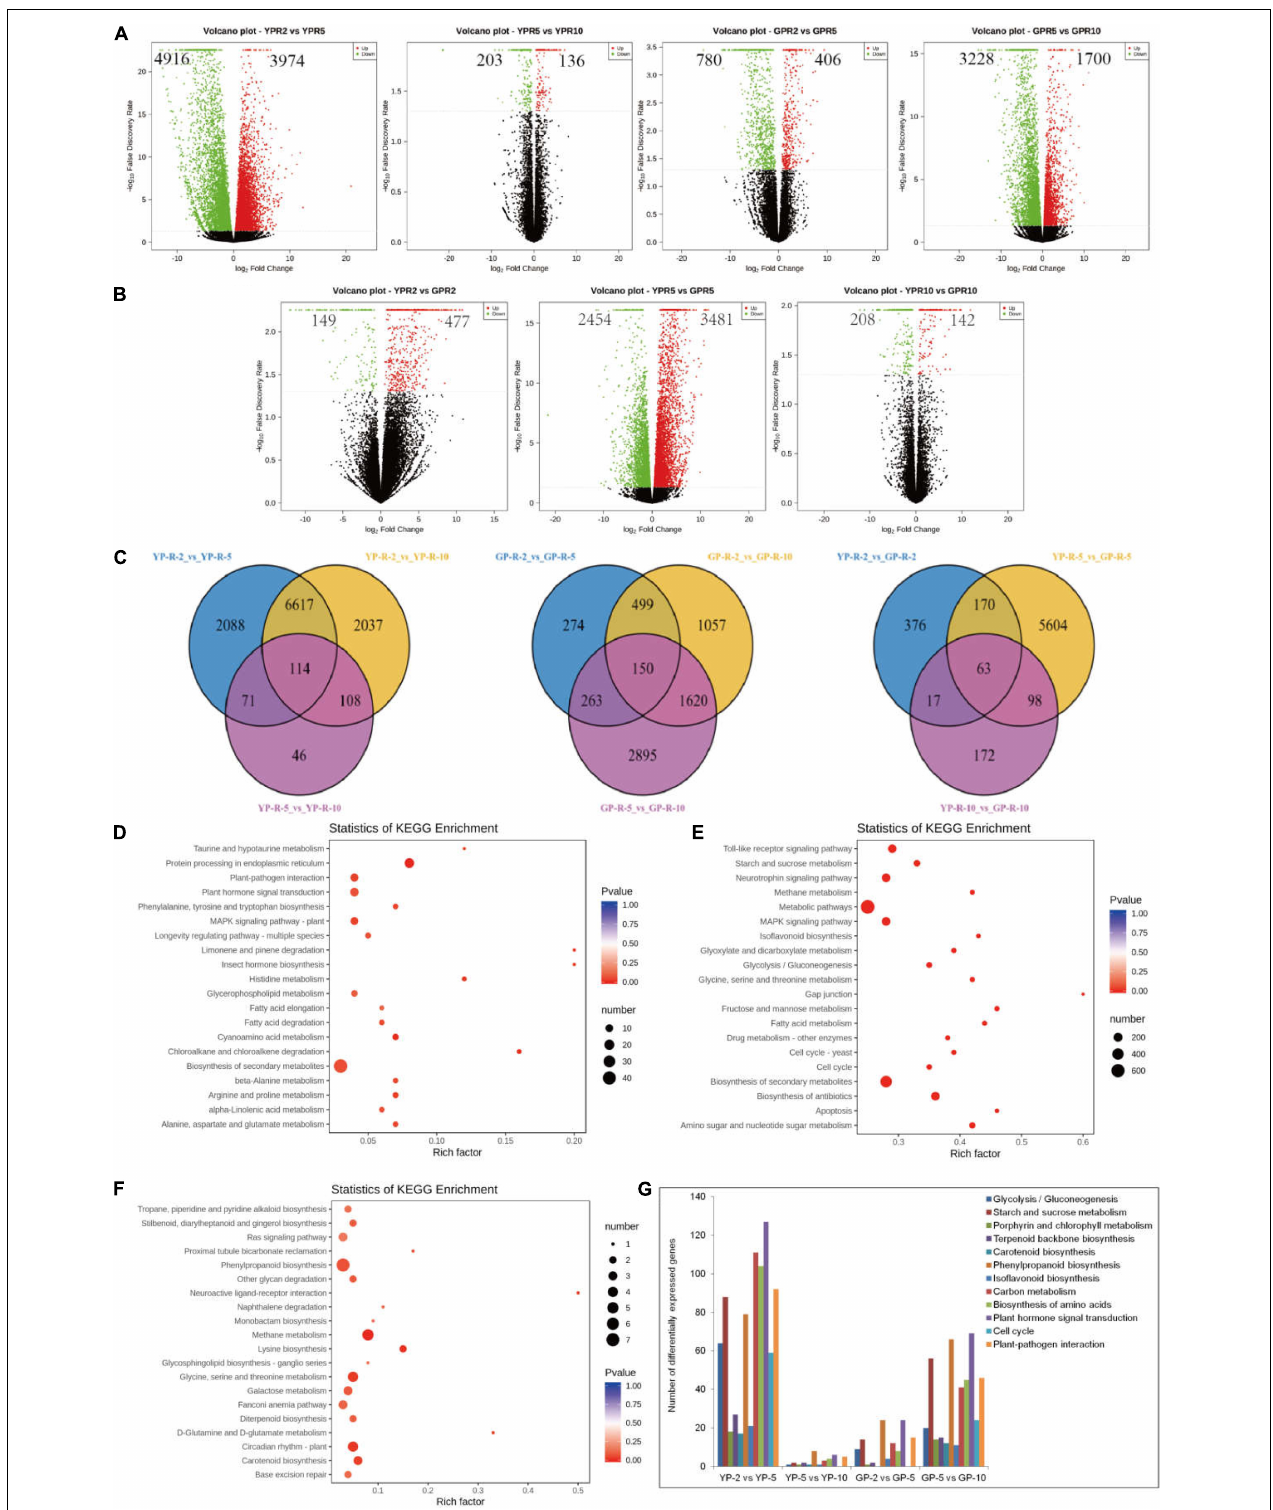
FIGURE 2 | The differential expression genes analysis between wild type and green pod mutant by transcriptome. (A,B) The volcano plot showing the number of differential expression genes between two comparative groups. (C) Venn diagram showing common and specific DEGs numbers from different combinations displayed in the overlapping and non-overlapping regions, respectively. (D–F) Top 20 significantly enriched KEGG pathways in (D) YP-2 vs. GP-2, (E) YP-5 vs. GP-5, and (F) YP-10 vs. GP-10. (G) The statistics of DEGs in some metabolic pathway at two developmental stages of wild type and green pod mutant.